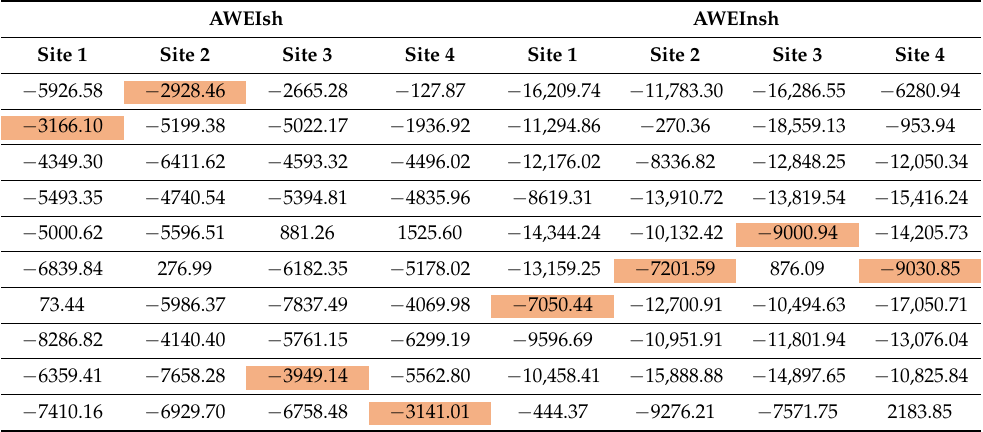
Table 2. The returned k cluster centers for AWEI as derived from k-means clustering analysis. The highlighted cluster centroid values fell in the color range of water on each index plot and had the highest overall accuracy as well as kappa, and thus selected as the optimum thresholds of the respective water indices for that